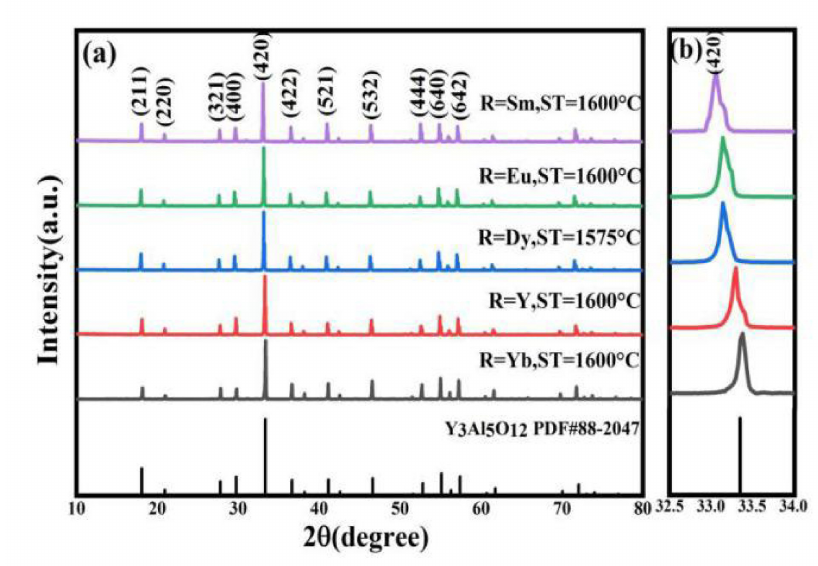
Figure 2. ( a ) XRD patterns of Y 2.95 R 0.05 MgAl 3 SiO 12 (R = Yb, Y, Dy, Eu, Sm) ceramic samples; ( b ) magnified XRD